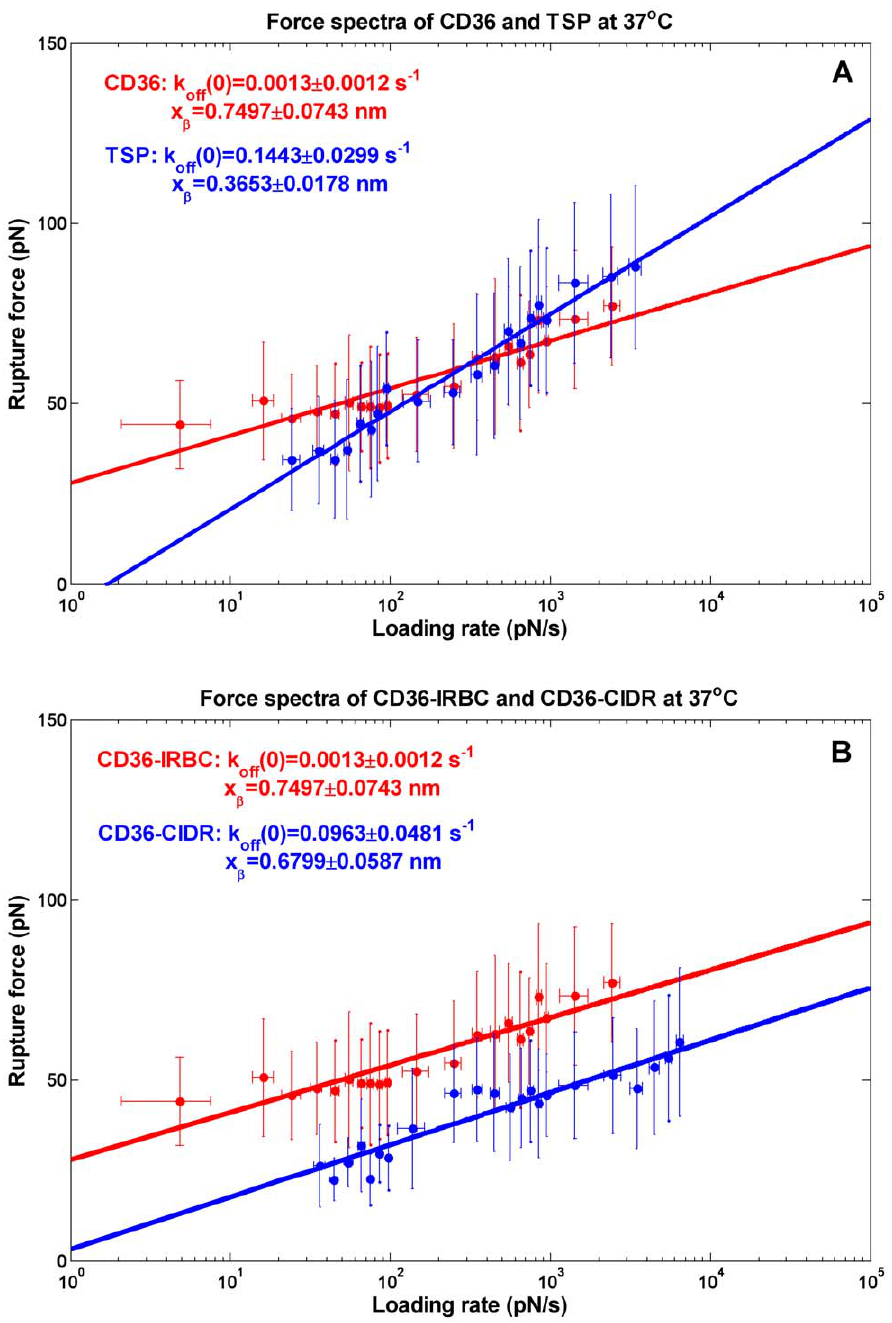
Figure 3. Force spectra and the extrapolated kinetic parameters. (A) CD36-IRBCs interaction and TSP-IRBCs interaction at physiological temperature (B) CD36-IRBCs interaction and CD36-CIDR interaction at physiological temperature. Mean rupture forces within each binned window of loading rates were used as pooled measures to fit to Bell-Evan’s model for the characteristic dynamic force spectra reconstruction.